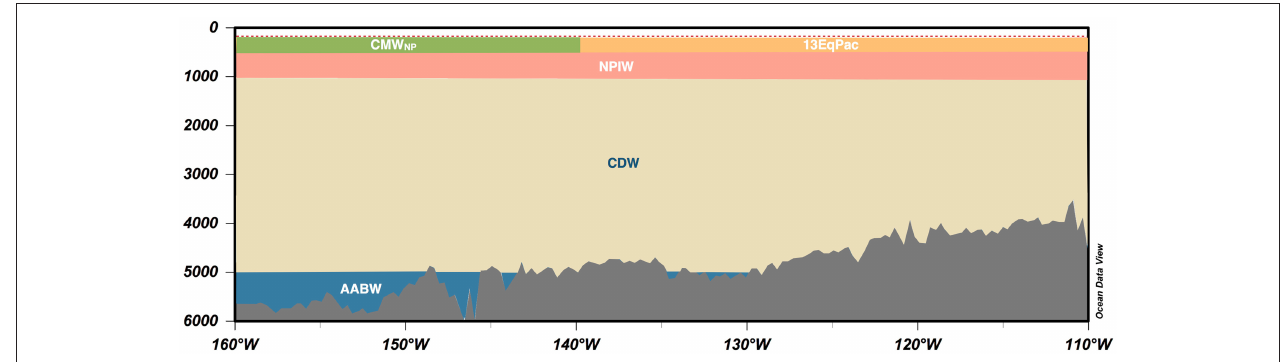
FIGURE 8 | Water masses in the CCZ region. The results are based on the water mass analysis performed in the Malaspina 2010 Circumnavigation (Catalá et al., 2015a,b). Only the most abundant water mass for each site was plotted. The dashed red line represents the upper limit of the water mass analysis (200m). The lower limit of the Malaspina water mass analysis was at 4,000m. Below this depth, the information has been extracted from Talley et al. (2011). AABW, Antarctic Bottom Water; CDW, Circumpolar Deep Water; NPIW, North Pacific Intermediate Water; CMWNP, North Pacific Central Mode Water; 13EpPac, Equatorial Pacific Central Water (13 ◦ C) (Tsuchiya,